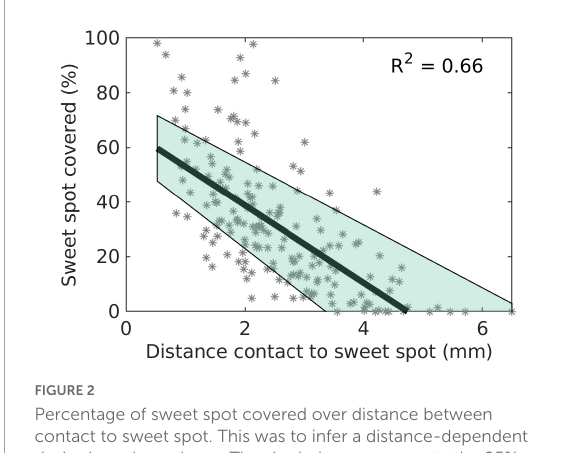
FIGURE2 Percentage of sweet spot covered over distance between contact to sweet spot. This was to infer a distance-dependent desired overlap volume. The shaded area represents the 95% confidence interval.